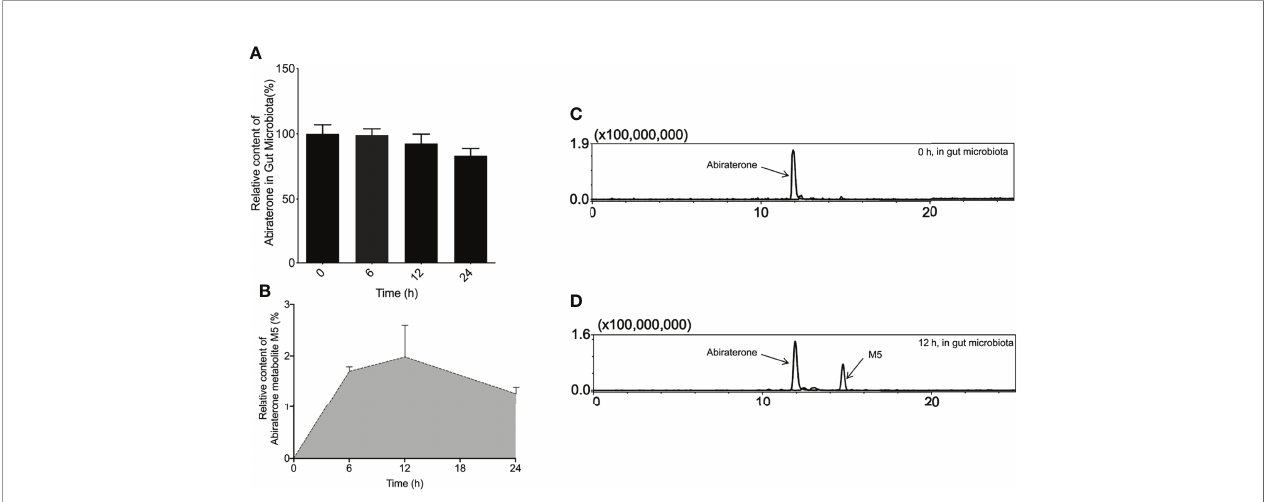
FIGURE 3 | The metabolites of Abiraterone from the gut microbiota. (A) The relative abundance of Abiraterone after incubation with rat gut microbiota for 0 h, 6 h, 12 h and 24 h. (B) The relative abundance of Abiraterone metabolite M5 after incubation with rat gut microbiota for 0 h, 6 h, 12 h and 24 h. (C) EICs of abiraterone after 0 h of incubation in the gut microbiota system. (D) EICs of abiraterone and metabolite M5 after 12 h of incubation in the gut microbiota system.